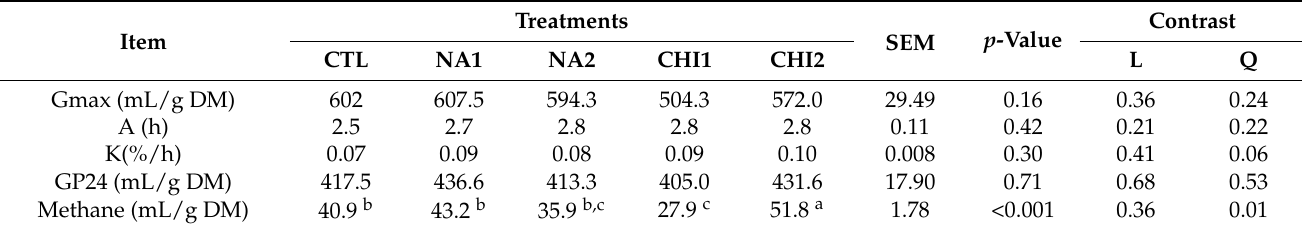
Table 3. Effect of addition of naringin and chitosan on in vitro methane